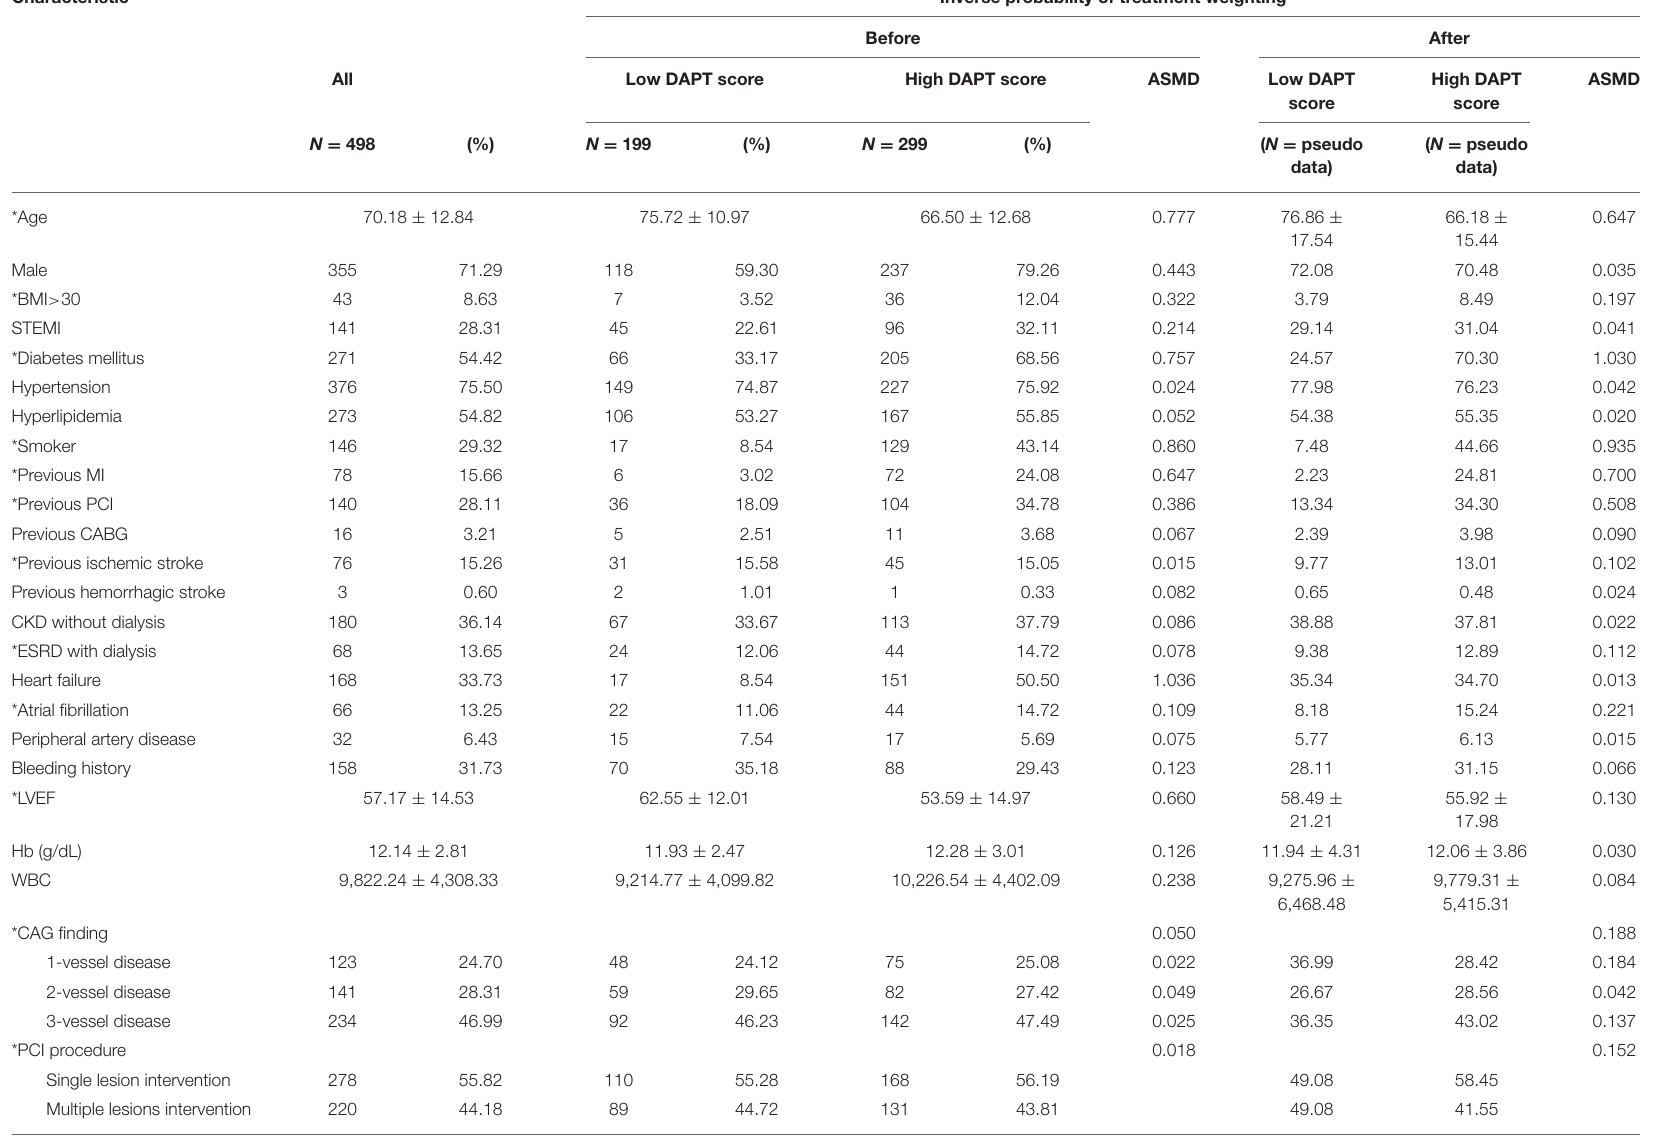
TABLE 2 | Baseline characteristics of patients with different DAPT scores. Characteristic Inverse probability of treatment